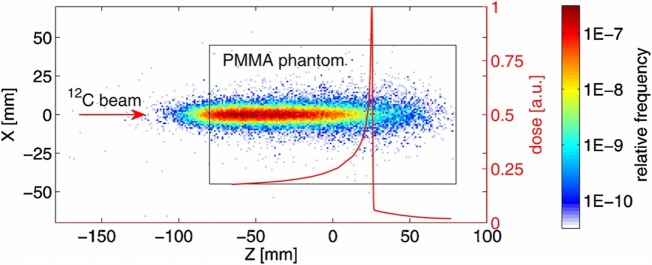
Distribution of the track back-projections for 5 × 104 measured secondary charged particles produced by the interaction of a carbon beam with a PMMA phantom at the HIT facility (26). The dimensions of the cylindrical PMMA phantom are illustrated by the black rectangle (view from the side). The origin of the coordinate system is aligned with the center of the phantom that was placed in the isocentre. The carbon ion beam was directed along the Z-axis. The depth dose distribution measured in water and scaled to the phantom water equivalent path length (WEPL) is shown by the red curve. Due to experimental limitations, the depth-dose distribution could be measured only for water depths greater than 20 mm. Initial carbon ion beam parameters: E = 250.08 MeV/u, FWHM = 4.3 mm. © Institute of Physics and Engineering in Medicine. Reproduced by permission of IOP Publishing. All rights reserved.